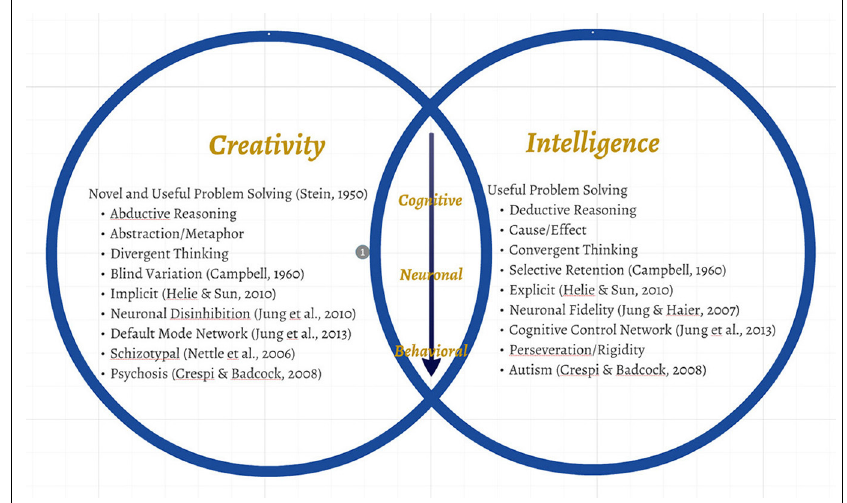
FIGURE 1 | Proposed model for dichotomy of reasoning pressures on human evolution with cognitive, neuronal, and behavioral